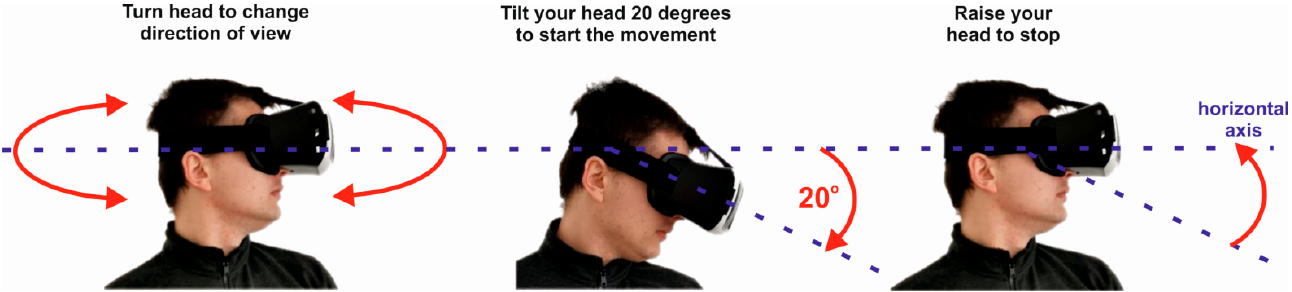
Figure 11. Movement control in the virtual world. Source: prepared by the author.